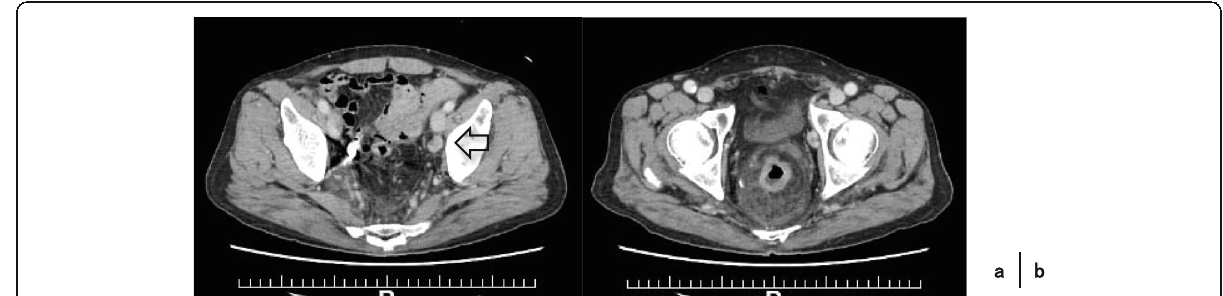
Fig. 2 a The left-sided lateral lymph nodes were swollen (arrow). b Fat concentration was